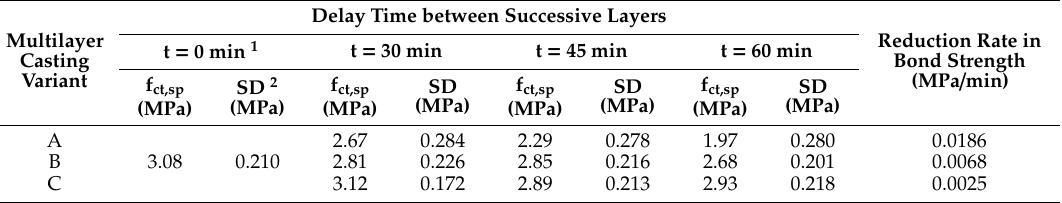
Table 4. Splitting tensile strength test results of multilayer cast